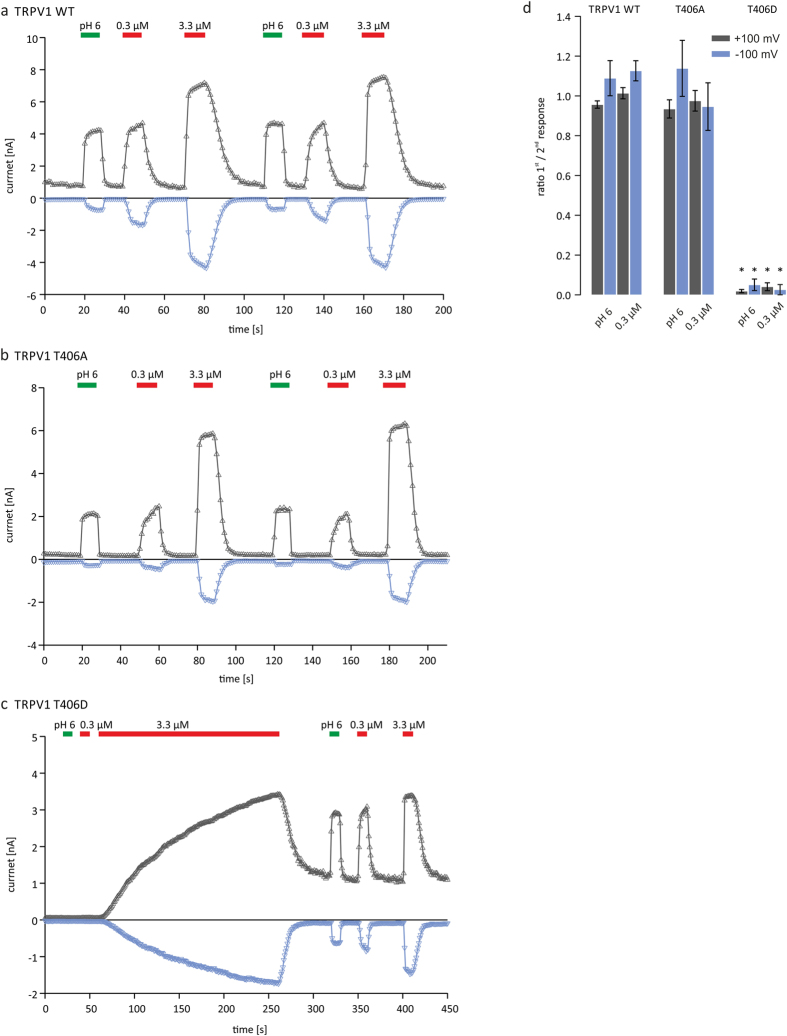
Sensitivity of TRPV1 to pH 6 is altered in the T406D mutant.pH 6, 0.3 μM and 3.3 μM capsaicin-induced currents of TRPV1WT and TRPV1T406 mutants in the absence of extracellular Ca2+. Application of Ringer’s solution at pH 6 or 0.3 μM capsaicin induces currents in TRPV1WT (a) and TRPV1T406A (b) receptor variants. TRPV1T406D expressing cells respond to pH 6 or 0.3 μM capsaicin only after priming the cells with 3.3 μM capsaicin (c). Ratio between first and second response indicates sensitization (<1) or desensitization (>1) during 3.3 μM capsaicin priming (d). Analysis of n = 10–15 independent measurements shows that TRPV1T406D is sensitized by priming with 3.3 μM capsaicin (unpaired WR-test, p < 0.05).